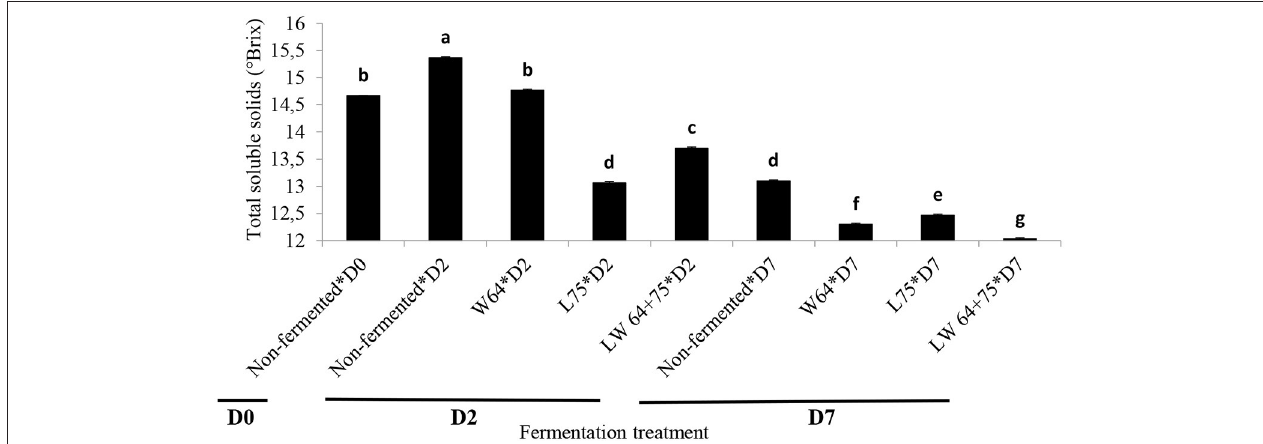
FIGURE 2 | Changes in total soluble solids during fermentation of smoothies. Bars with different alphabetic letters are significantly different at p < 0.0001 level. W64, Weissella cibaria 64; L75, Lactobacillus plantarum 75 ; LW64 + 75, W. cibaria 64 + L. plantarum 75; D0, day 0; D2, 2 days; D7, 7 days; non-fermented smoothies